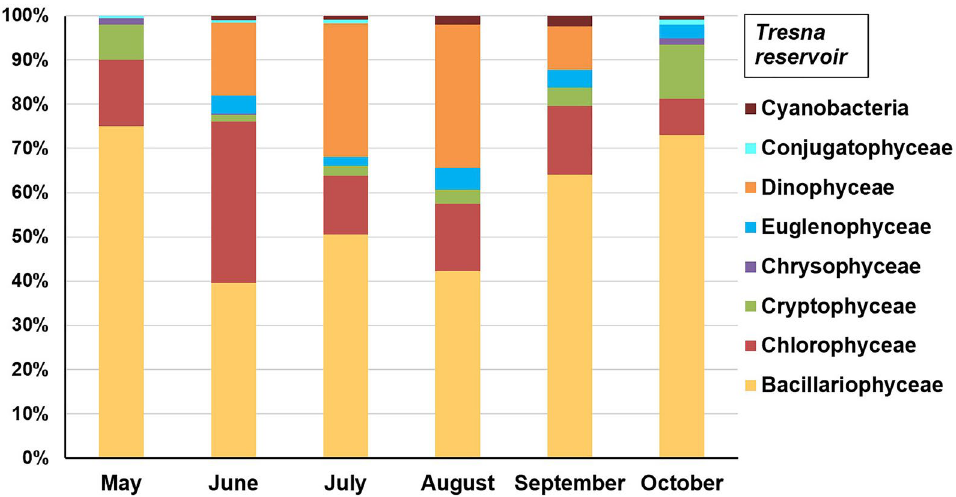
Figure 5. Structure of planktonic algae groups in the Tresna Reservoir in 2019